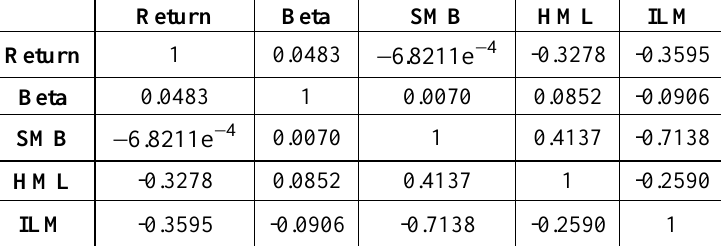
Table 1. Correlation Coefficient of Variables at the First Level